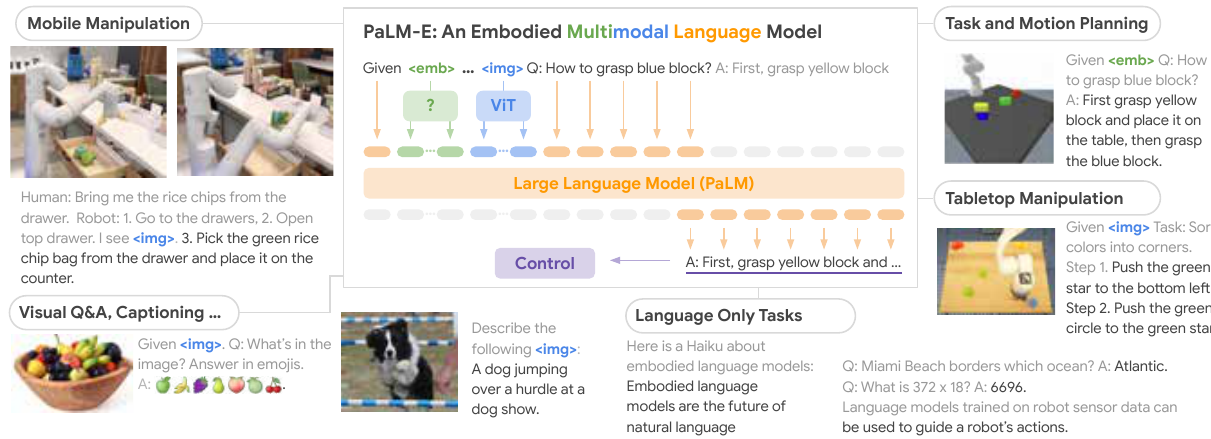
Figure 1: PaLM-E is a single general-purpose multimodal language model for embodied reasoning tasks, visual-language tasks, Figure 11 Schematic diagram of working strategy of PaLM-E and applicable into downstream tasks. PaLM-E can use visual data to improve its language and language tasks. PaLM-E transfers knowledge from visual-language domains into embodied reasoning – from robot planning in processing skills, create language that explains images, and give instructions to control robots to do complex tasks. PaLM-E is a decoder only LLM that can environments with complex dynamics and physical constraints, to answering questions about the observable world. PaLM-E operates on produce text completion in an autoregressive way with a given prefix or prompt. It uses multimodal statements that have visual, continuous state estimation, multimodal sentences , i.e. sequences of tokens where inputs from arbitrary modalities (e.g. images, neural 3D representations, or states, in text and so on as its training data [28]. green and blue) are inserted alongside text tokens (in orange) as input to an LLM, trained